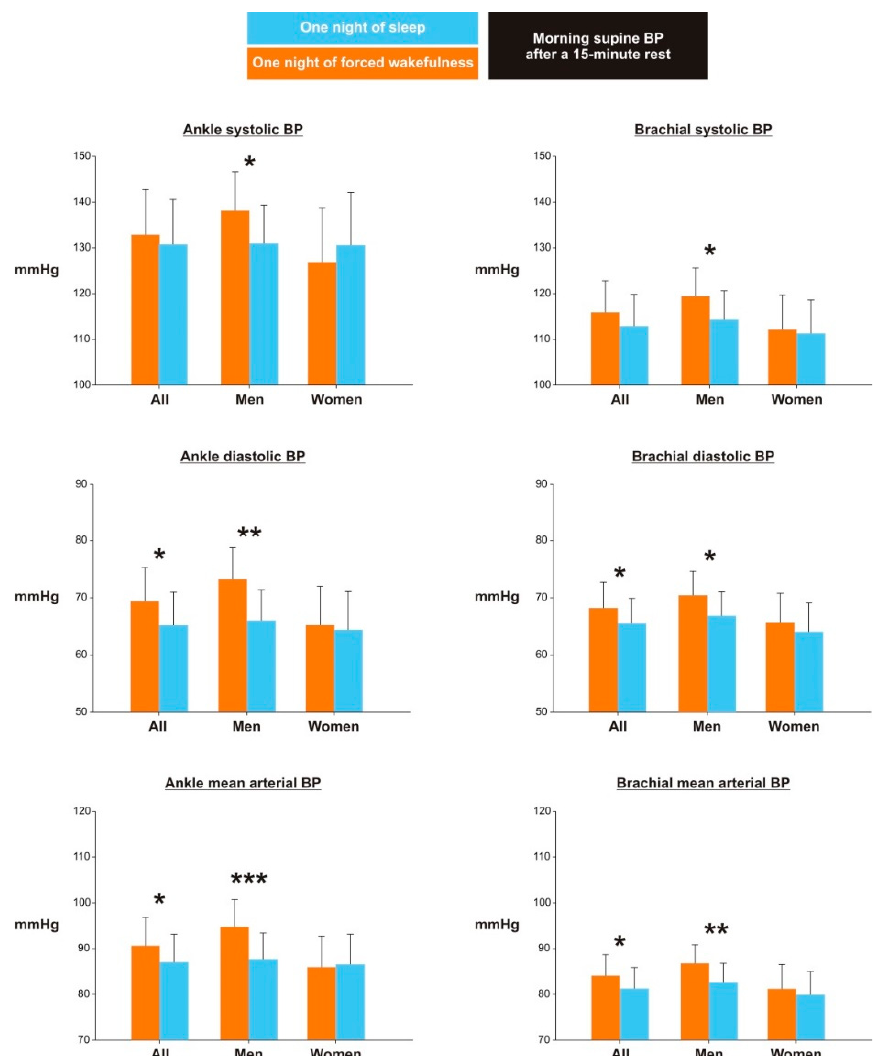
Figure 1. Effects of overnight wakefulness on arterial blood pressure. Estimated marginal means ± standard error and p -values derived from generalized linear mixed models, assuming an unstructured covariance matrix and using a normal distribution with an identity link function. Orange: overnight wakefulness condition, blue: sleep condition. * p < 0.05, ** p <0.001, and *** p ≤ 0.001 for pairwise contrasts. Abbreviations: BP, blood pressure; mmHg, millimeter mercury.